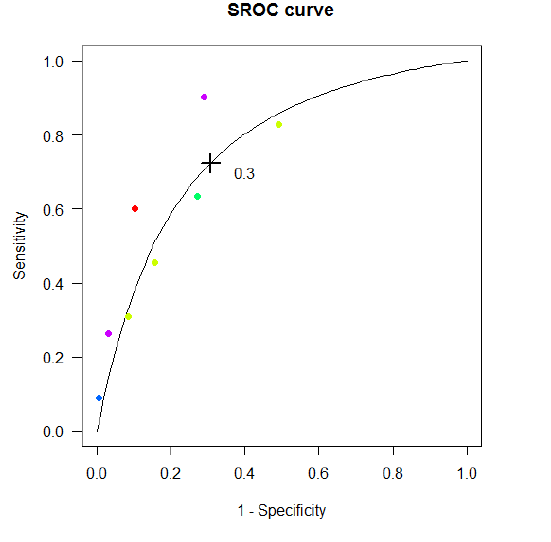
Figure 2. Multiple thresholds ( a ) SROC and ( b ) ROC curves for FibroTest in detecting advanced fibrosis. Each point represents a reported threshold value, points of the same color represent thresholds reported within the same study. The cross in the SROC curve indicates the Youden-based threshold value: Youden-threshold: 0.30, sensitivity: 0.72 (95% CI: 0.52; 0.87), specificity: 0.69 (95% CI: 0.49; 0.84), AUC: 0.77 (95% CI: 0.64; 0.86).